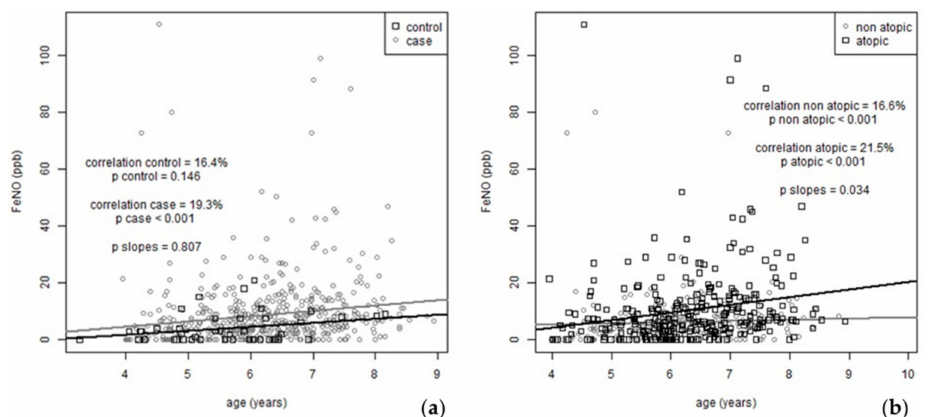
Figure 1. ( a ) Non-parametric correlation between subjects’ fractional exhaled nitric oxide (FeNO) and age, separately assessed in controls and cases. “P slopes” denote the p-value of the comparison between the slopes of the two separate trend lines, i.e., controls (black line) vs. cases (gray line). ( b ) FeNO progression slopes in preschool asthmatics for atopics (black line) and non-atopics (gray line), at baseline and during the 2-year